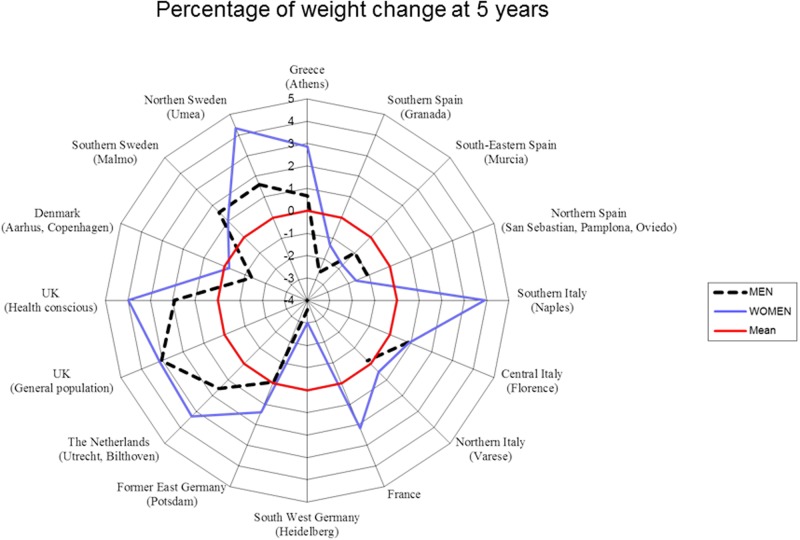
The EPIC regions (n = 16) were ordered from South to North.These geographical regions were designated by grouping some of the 23 EPIC centers together: France (Paris and surroundings), Northern Italy (Varese), Central Italy (Florence), Southern Italy (Naples), Northern Spain (San Sebastian, Navarra, Asturias), South-Eastern Spain (Murcia), Southern Spain (Granada), Greece (Athens and other regions), Northern Sweden (Umeå), Southern Sweden (Malmö), Denmark (Aarhus and Copenhagen), UK (Oxford, the health conscious group, vegans and ovo-lacto-vegetarians), UK (Cambridge, the General population), The Netherlands (Utrecht and Bilthoven), former East Germany (Potsdam), and South-West Germany (Heidelberg).